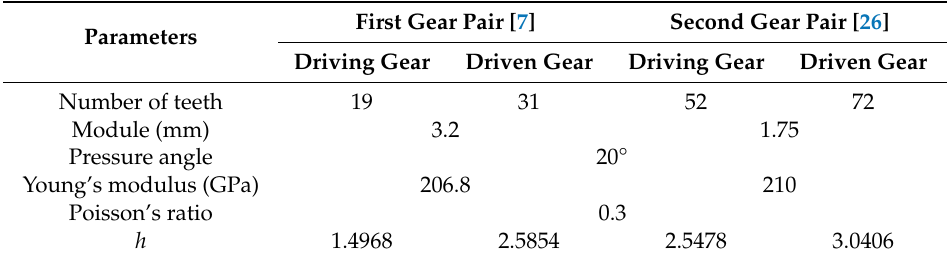
Table 9. Physical parameters of two spur gear